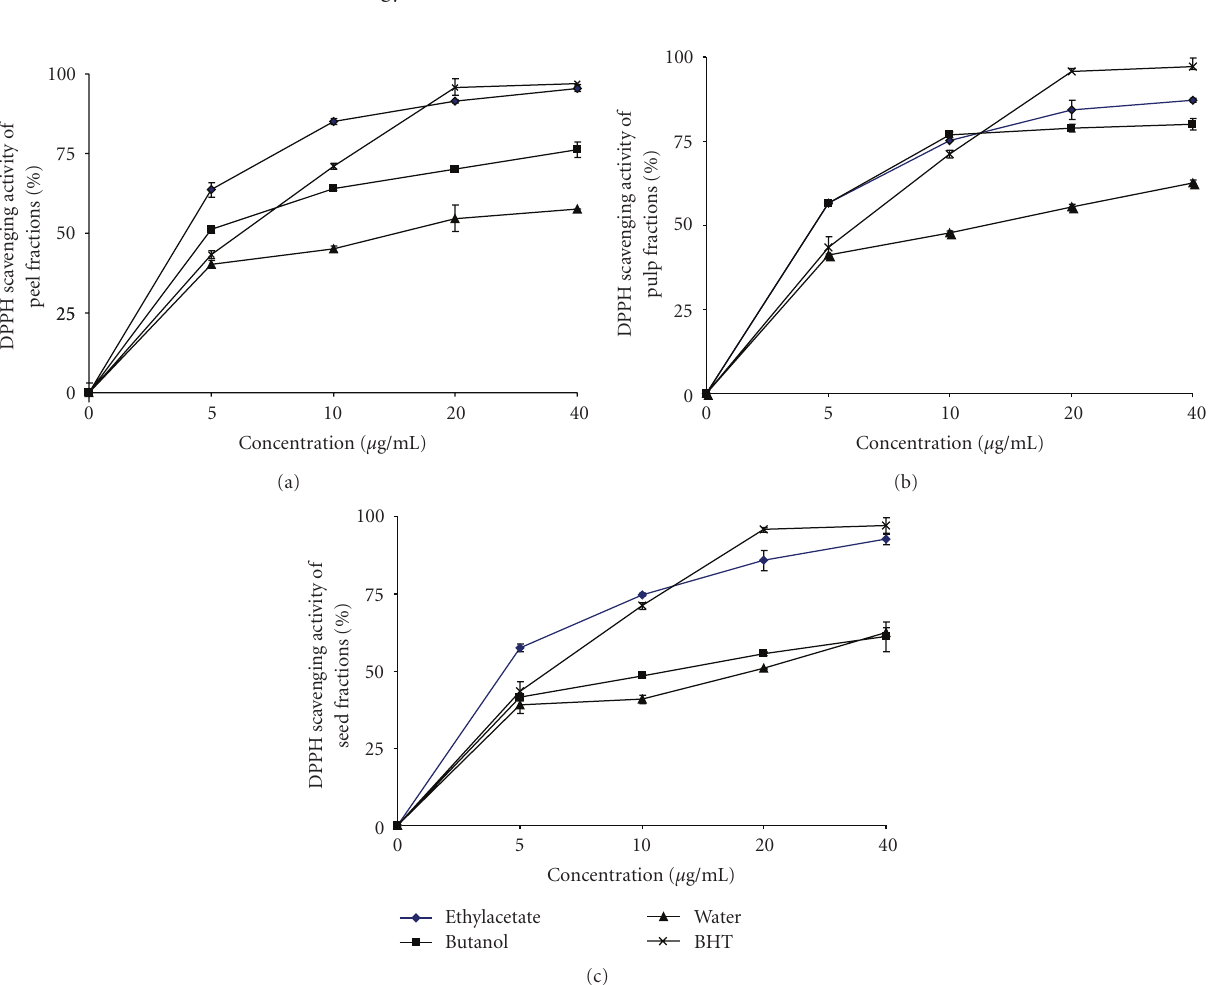
Figure 2: DPPH radical scavenging activity of Canarium odontophyllum peel fractions (a), pulp fractions (b), and seed fractions